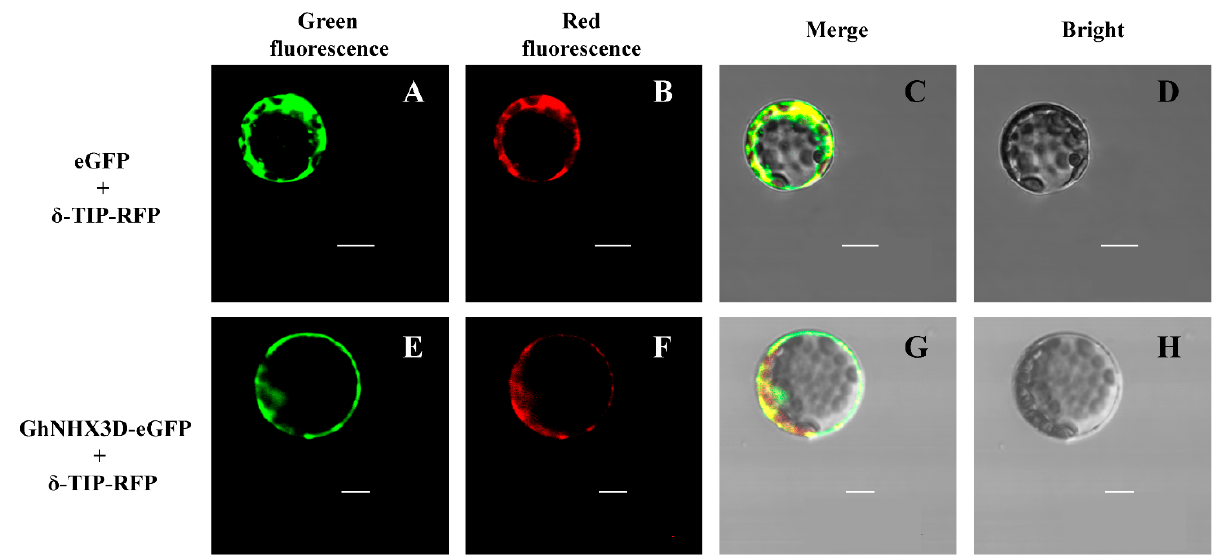
Figure 2. Subcellular localization of GhNHX3D-eGFP in Arabidopsis protoplasts. GhNHX3D fused with eGFP ( A – D ) and δ -TIP fused with red fluorescent protein (RFP) ( E – H ) were transiently expressed in Arabidopsis protoplast cells. δ -TIP protein is a localization marker for the vacuolar membrane. Bar = 10 μ m.